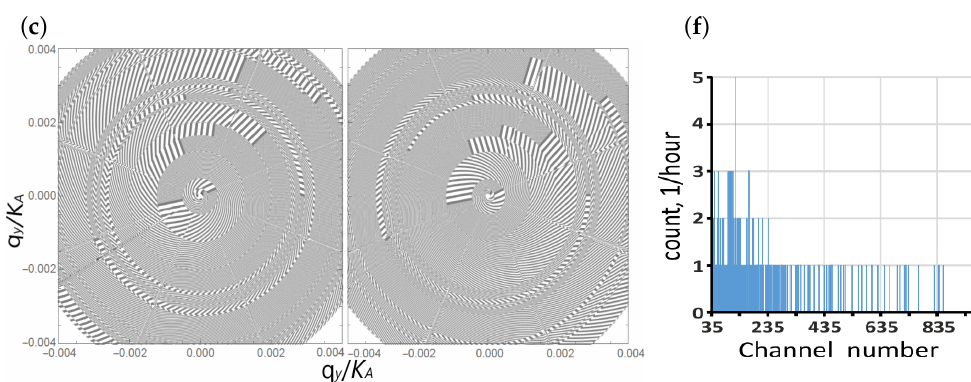
Figure 2. ( a ) Schematic of irradiation of a sample (underneath the collimator of length L ) of diameter D s . Inset: radiation-induced CNT defects as neutral graphene vacancies V 0 g with knock-on neutral atoms C 0 . ( b ) Schematic of the ionization radiation impact. The knock-on C atoms are fixed on a nanotube wall (graphene rolled-up monolayer) by irradiation defect vortical pairs (pseudo-Majorana + + − − V − fermions), V p p , schematically imaged in ( b ). Confining the vortices V p and antivortices V p from the pairs near the points K and K (cid:48) of the graphene Brillouin zone, respectively, the hexagonal symmetry binds the pseudo-Majorana quasiparticles. Each pair of bound pseudo-Majorana fermions produces a very high number (avalanche) of electrons and holes. The gamma and beta rays are indicated by γ and e − , respectively. ( c ) The vortex texture as contour plots of the graphene electron (left) and hole (right) bands shown in Figure 1. The radiation spectra R Cs ( d ) and R Cs / CNT ( e ) for the IRS 137 Cs photon beam incoming through the collimator without and with the bilayer, respectively, and scattered on the detector crystal. The backscatter peak, the photopeak, the characteristic X-ray peak, and the contribution from the bremsstrahlung are labeled as “BS”, “Ph”, “X”, and “Brem”, respectively; the bilayer photon escape peaks corresponding to the graphene − γ -ray interaction producing the pseudo-Majorana chiral, semichiral, and nonchiral fermions are labeled as “ V ch ”, “ V sc ”, and “ V nc ”, respectively. The single Compton continuum and area of multiple Compton scattering are labeled as “Single Compton” and “Multiple Compton”, respectively. The radiation background has been subtracted from the radiation spectra. ( f ) The radiation